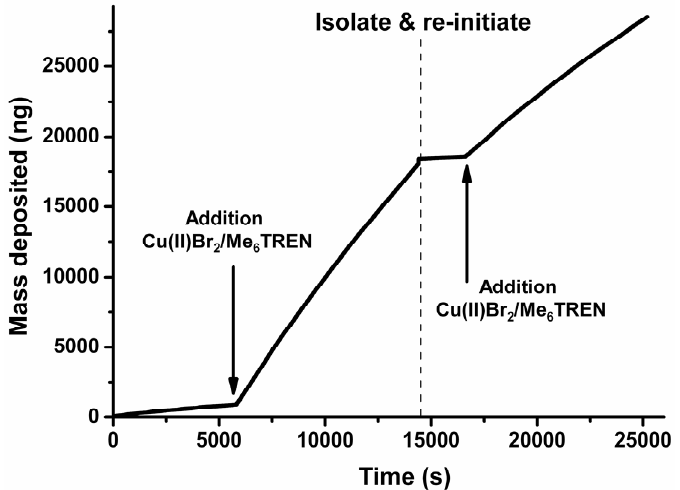
Figure 4. Cumulative E-QCM profile of HEMA polymerization via surface initiated e -ATRP. The profile shows a large increase in mass only after the addition of Cu(II)Br /Me TREN complex. It is shown that the polymerization reaction can 2 6